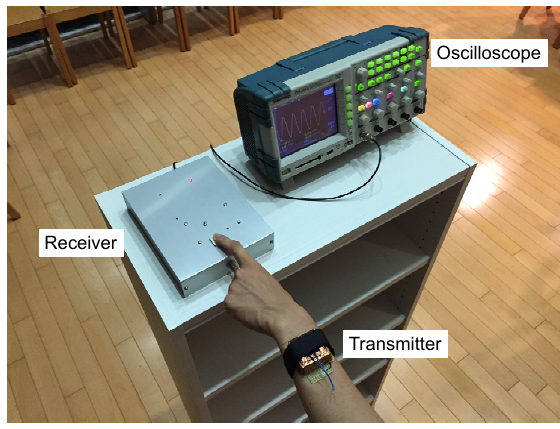
Figure 6. Experimental setup (photograph).